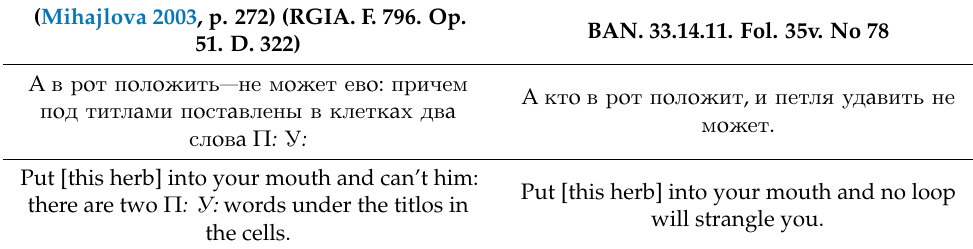
Table 4. Texts about the Muravey plant.